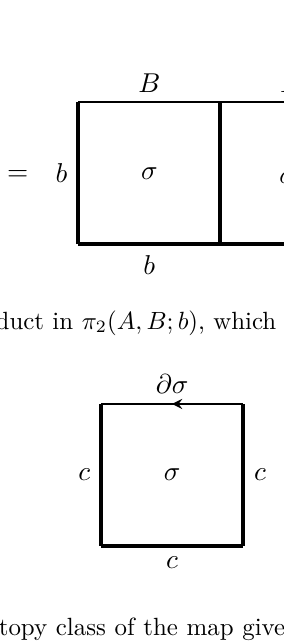
Figure 2 . Illustration of conditions satisfied by maps representing elements of the second relative homotopy group π ( A, B ; b ) . 2